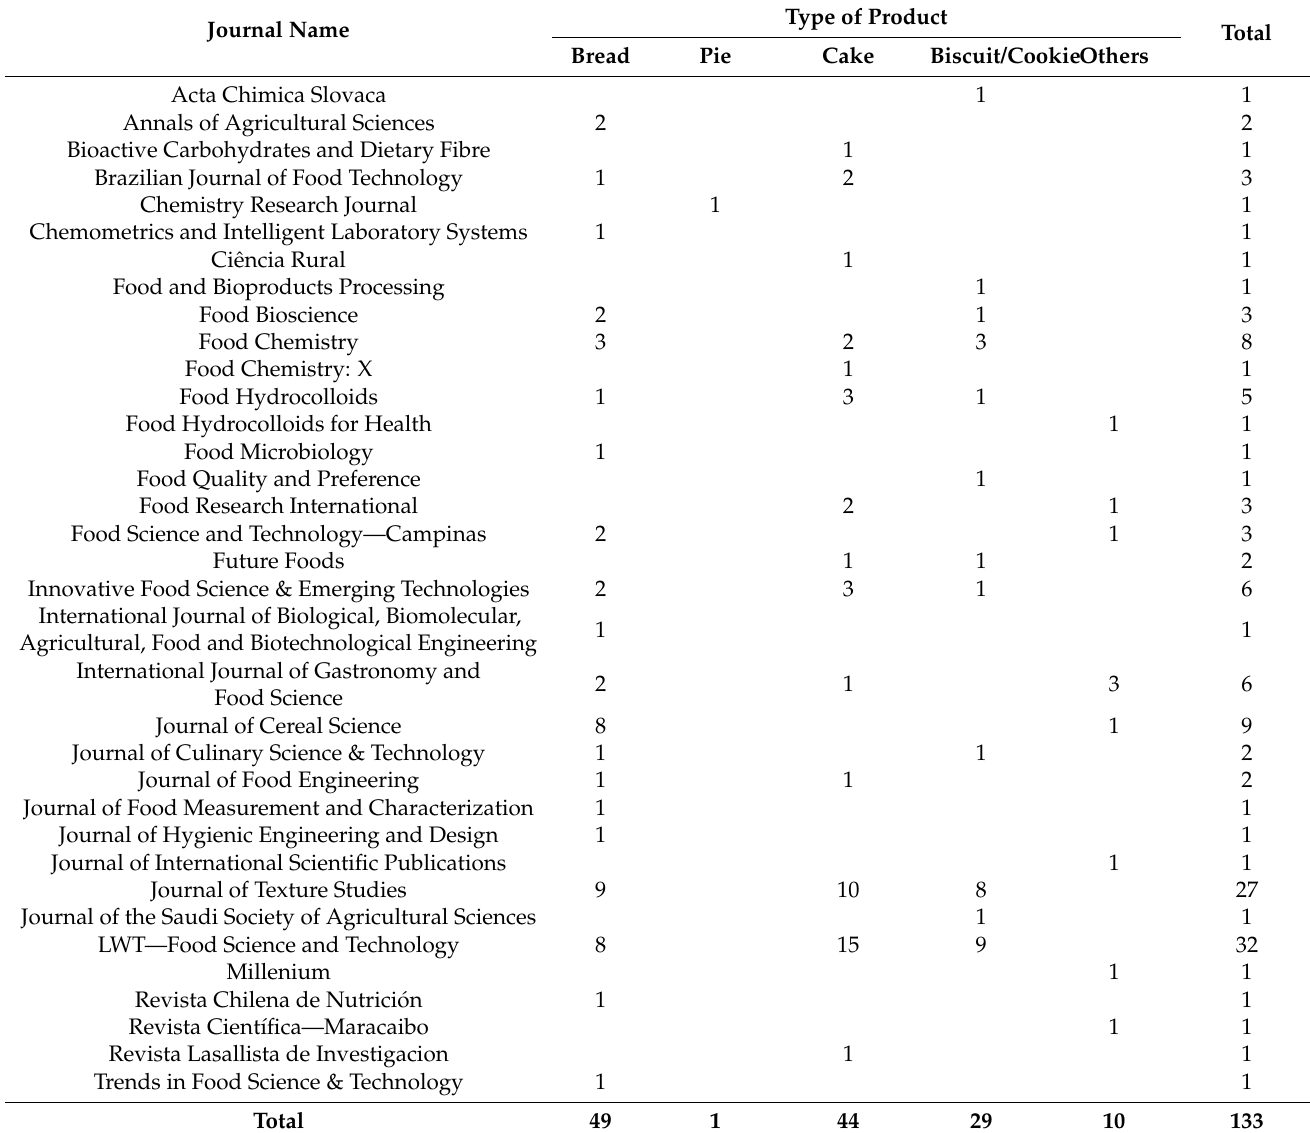
Table 1. Number of studies according to journal and product